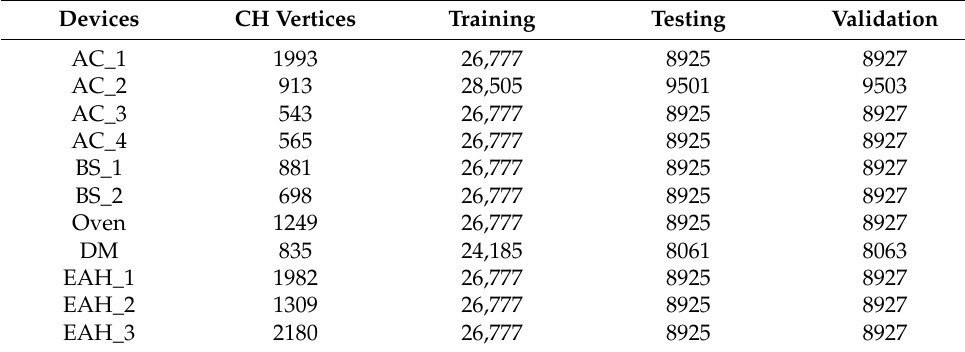
Table 21. Data selection results for estimation models.